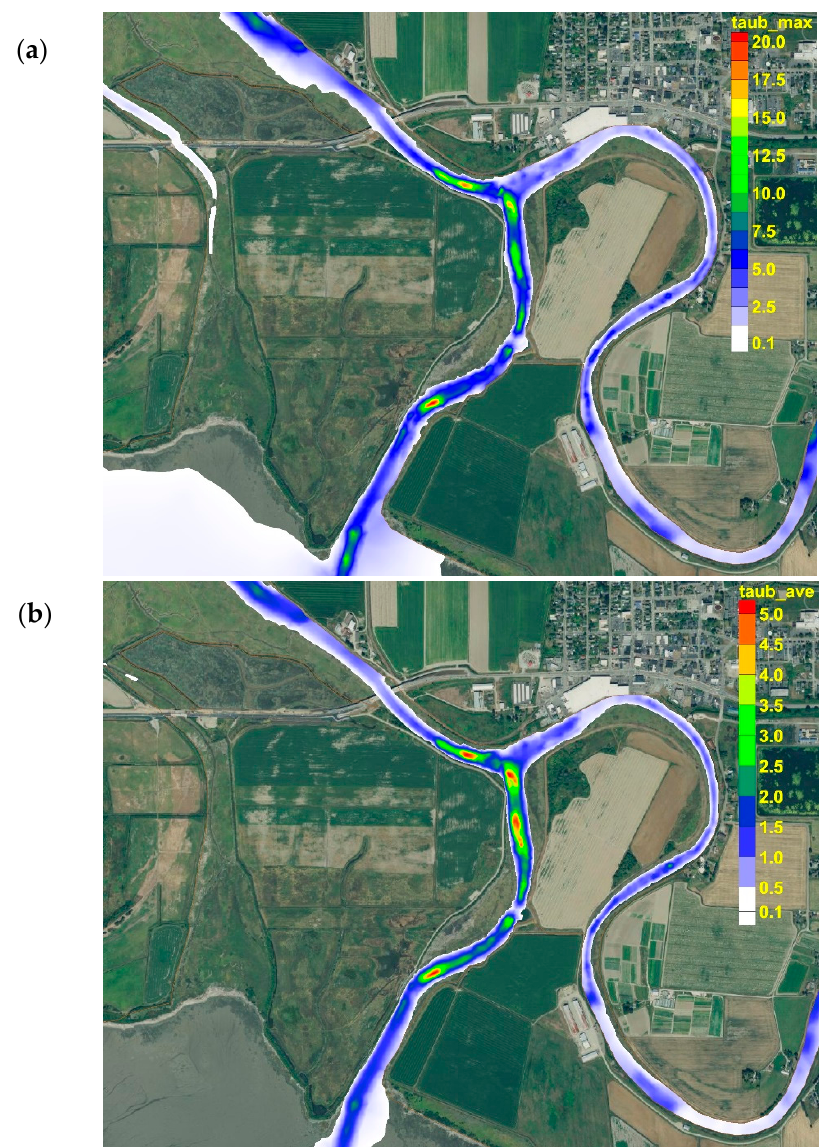
Figure 10. Horizontal distribution of maximum ( a ) and mean bed shear stress in Pa ( b ) for the baseline scenario for the high-flow (bank-full) condition at 750.62 m 3 /s.